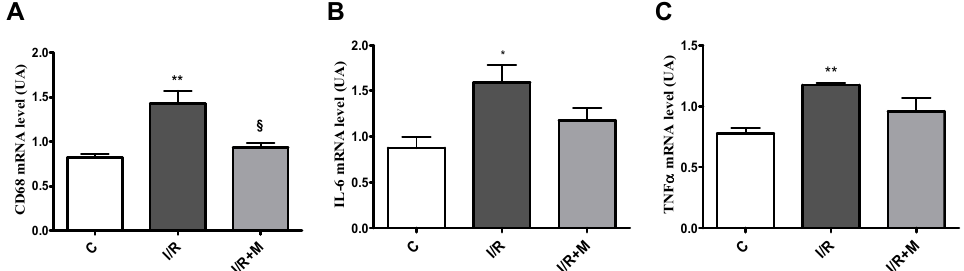
Figure 5. Effect of metformin treatment on cardiac expression of CD68, IL-6 and TNF- α in a mouse model of I/R injury. qRT-PCR quantification of the expression level of CD68 ( A ), IL-6 ( B ) and TNF- α ( C ), n = 4–5. Data are presented as mean ± SEM. One-way ANOVA followed by Bonferroni’s post hoc test: * p < 0.05 vs. control (C), ** p < 0.01 vs. control (C), § p < 0.05 vs. I/R.